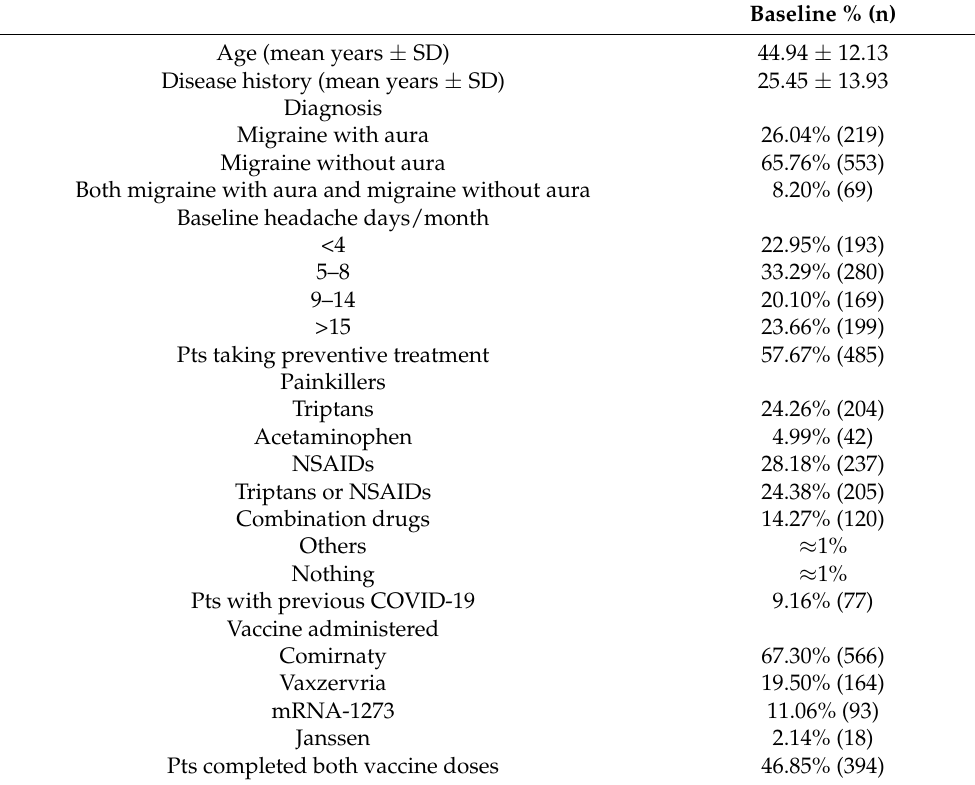
Table 1. Baseline characteristics of migraine patients filling in the questionnaire (841